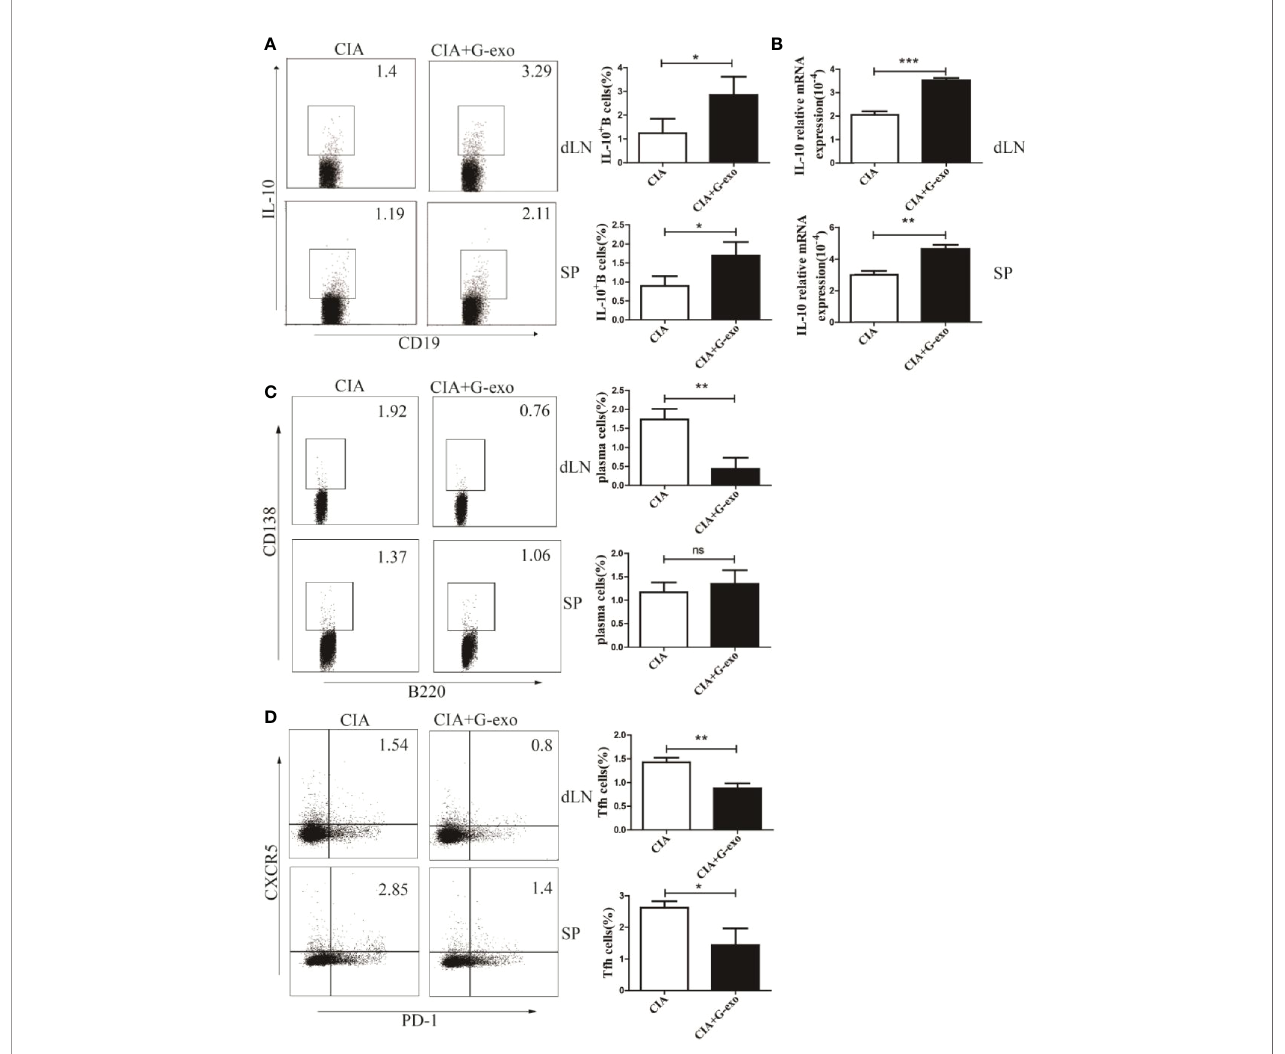
FIGURE 3 | G-exoincreaseIL-10 + BcellsbutdecreasestheproportionofplasmacellsandfollicularhelperTcellsinCIA. (A) Proportionsofinterleukin-10(IL-10) – producingBcellsin drainagelymphnodes(dLNs)andspleensfromCIAmicetreatedwithG-exo(CIA+G-exo)orcontrolmice(CIA)wereanalyzedbyFCM. (B) ThelevelofIL-10mRNAindLNs(up)and spleens(down)wasdeterminedbyRT-qPCR. (C) TheproportionofB220 - CD138 + plasmacellsindLNsandspleenswasanalyzedbyFCM. (D) TheproportionofCD4 + CXCR5 +